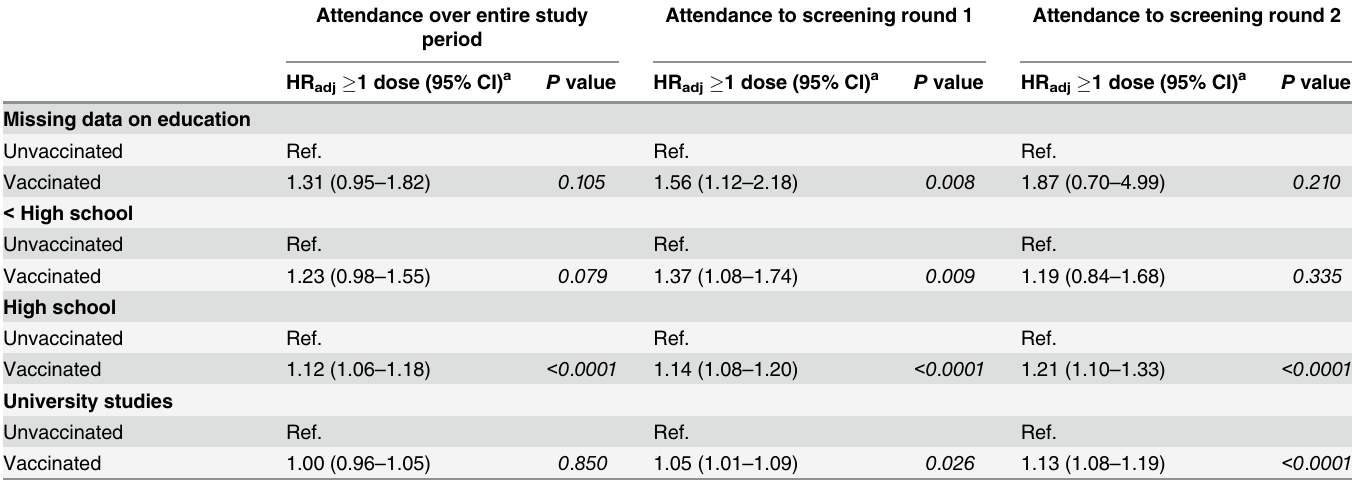
Table 3. Adjusted hazard ratios of screening attendance by HPV vaccination status and education level during the entire study period, and by round 1 and 2 during